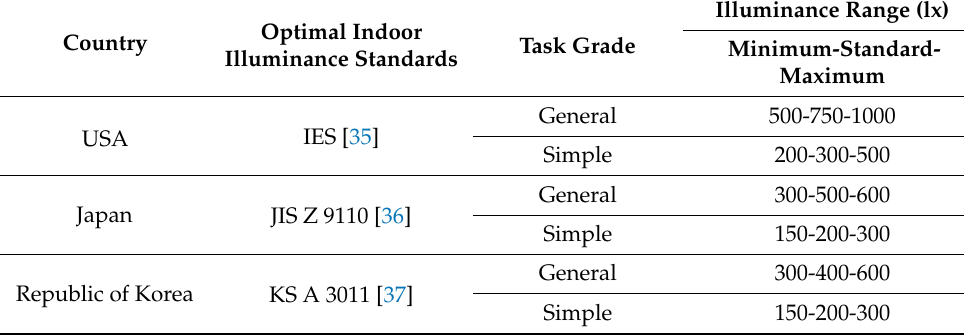
Table 2. Indoor illuminance standards for visual work in the US, Korea, and Japan.